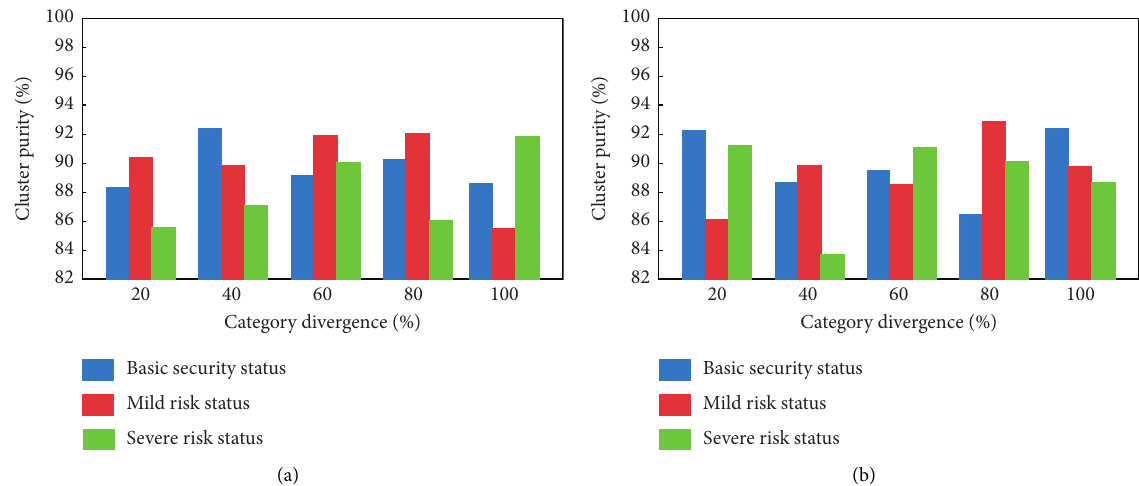
Figure 6: Cluster purities of three different risk statuses for similarity measure (a)and item clustering